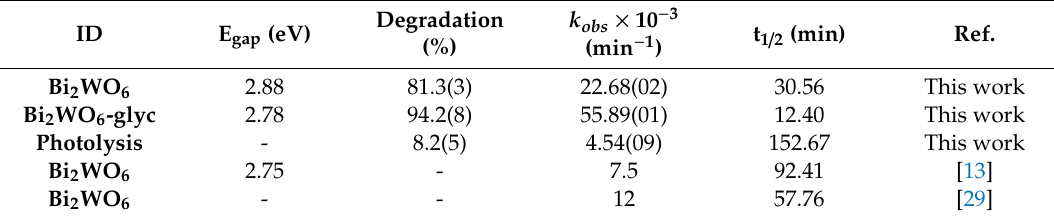
Table 2. Optical band gap (E gap ), degradation rate, observed reaction rate constant ( k obs ), half-life time (t 1 / 2 ) for Bi 2 WO 6 , Bi 2 WO 6 -glyc, and photolysis, and some results reported in references under the photodegradation of RhB